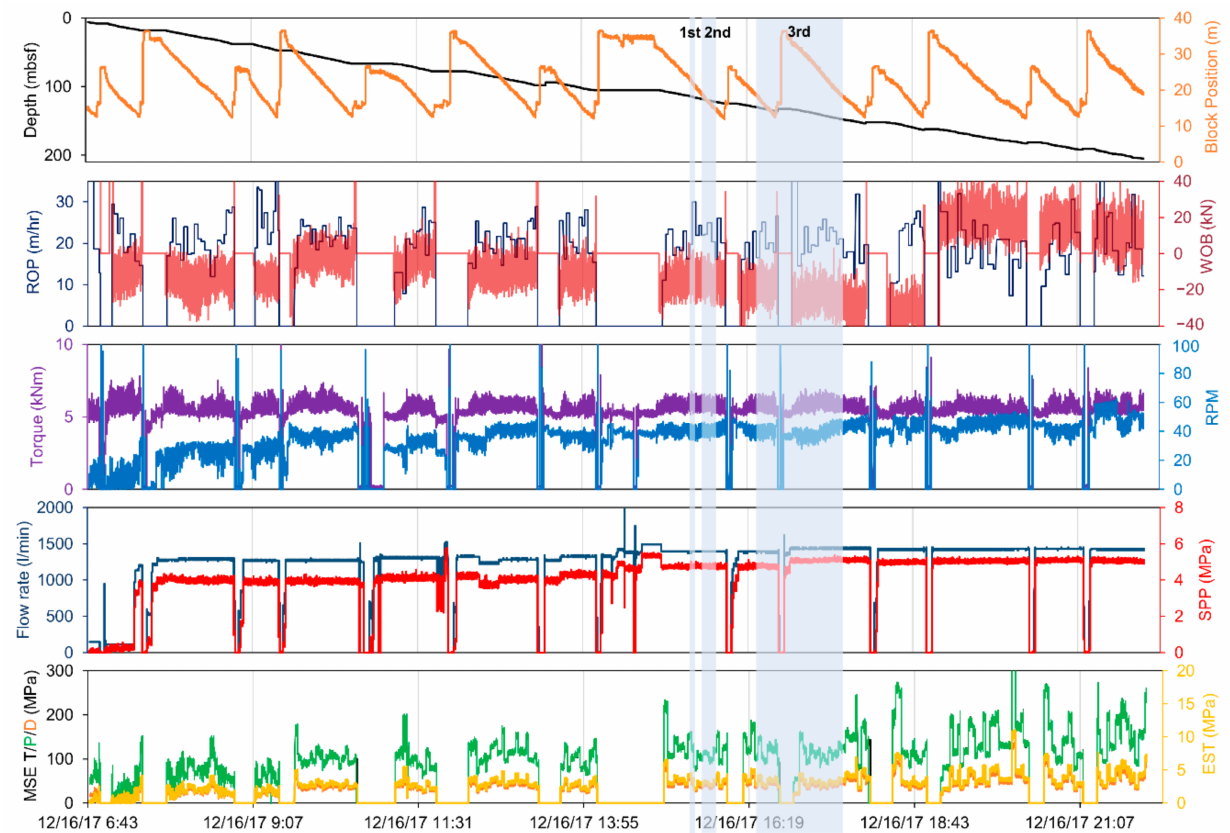
Figure 9. Time-based series for wellbore U1517A. Shaded areas present the three gas hydrate intervals detected in the wellbore by MWD/LWD logging